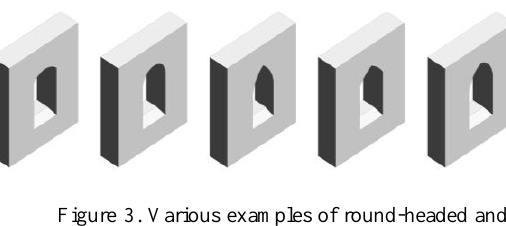
Figure 3. Various examples of round-headed and pointed arch configurations producible with the single parametric opening model.